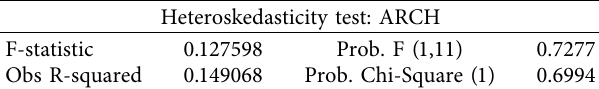
Table 9: Heteroscedasticity test results of residual